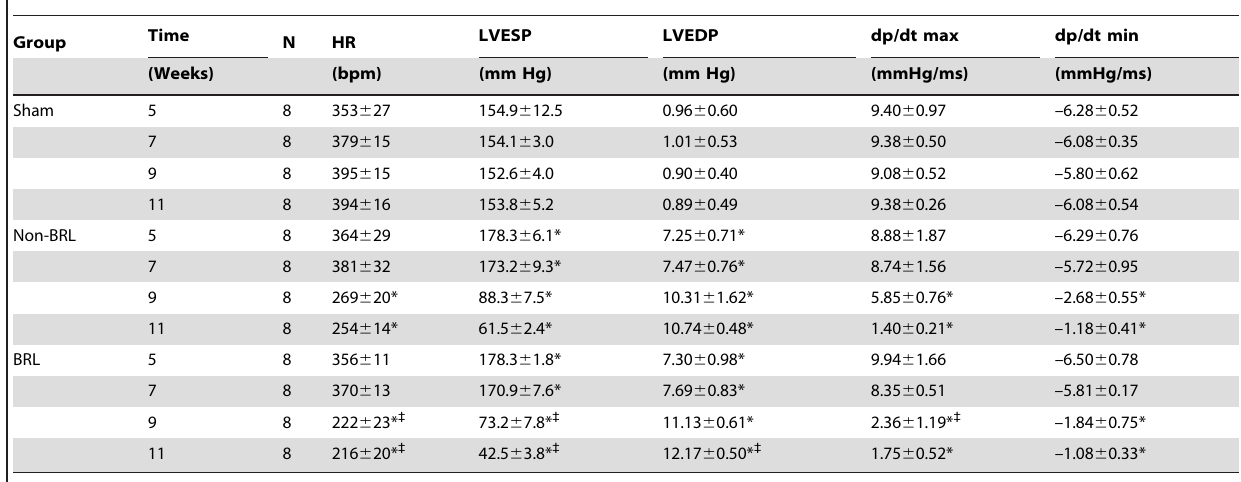
Data are presented as means 6 standard error. Sham: control group; Non-BRL: HF group without BRL37344 injection; BRL: HF group with BRL37344 injection; HR: heart rate; LVESP: left ventricular end-systolic pressure; LVEDP: left ventricular end-diastolic pressure; dp/dt max: maximum rate of rise of left ventricular pressure; dp/dt min: maximum rate of fall of left ventricular pressure. * P , 0.01 vs. Sham group;